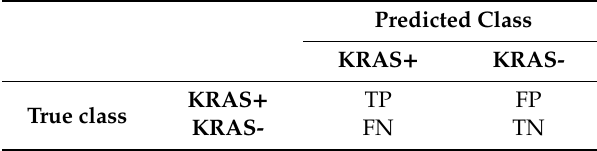
Table 1. Representation of a confusion matrix used to visualize the classifier performance. Each column in the matrix represents the instances in the predicted class while each row represents the instances in the true